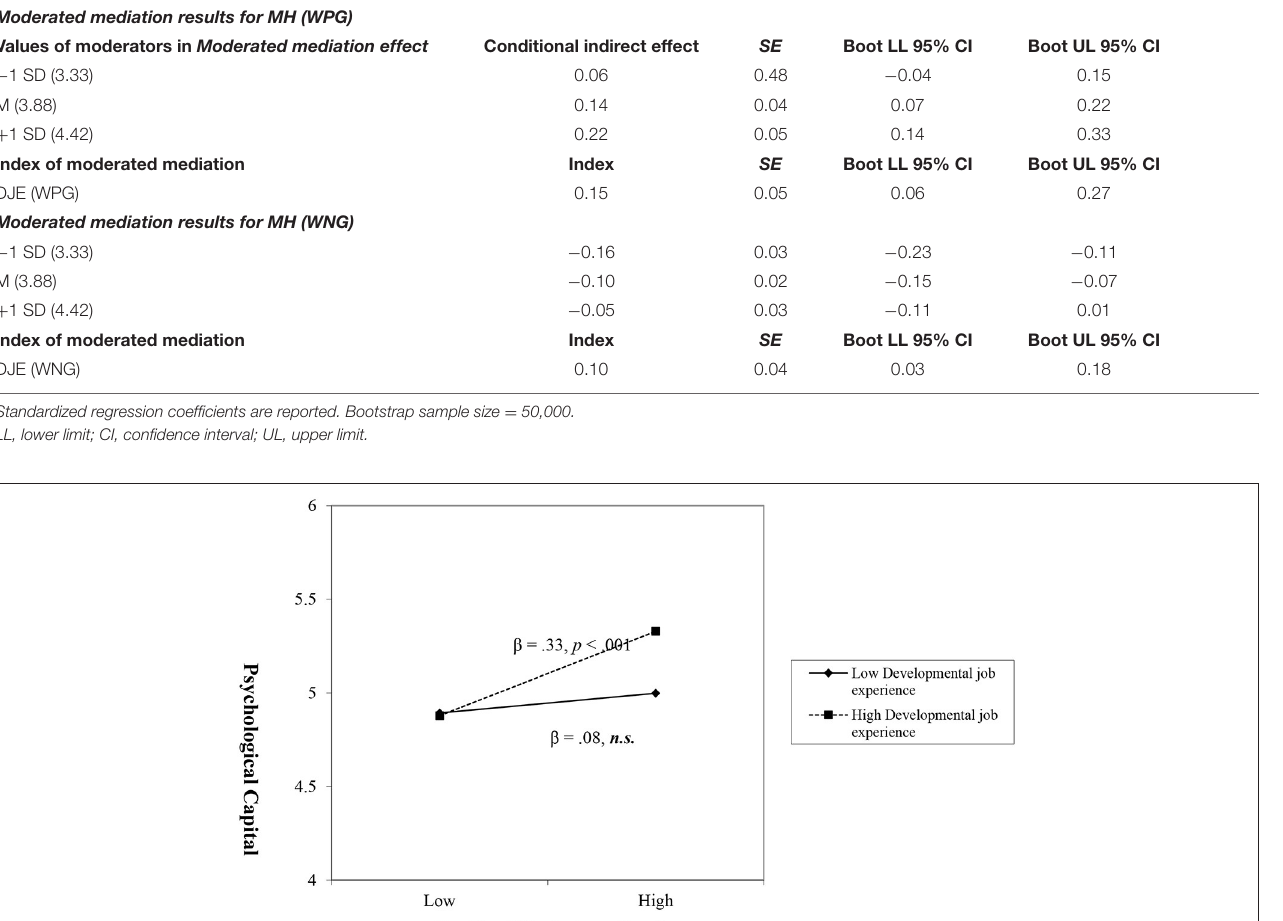
WG should be assessed (2, 3), and although WPG is a deviant behavior, it has potential for serving a social function at